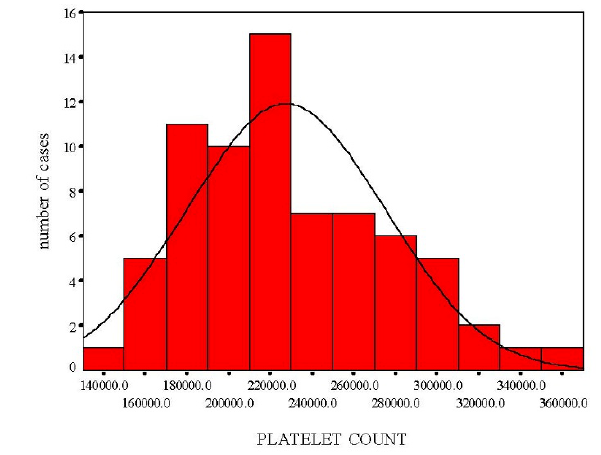
Figure 1 Histogram showing the normal distribution of plate- let count.